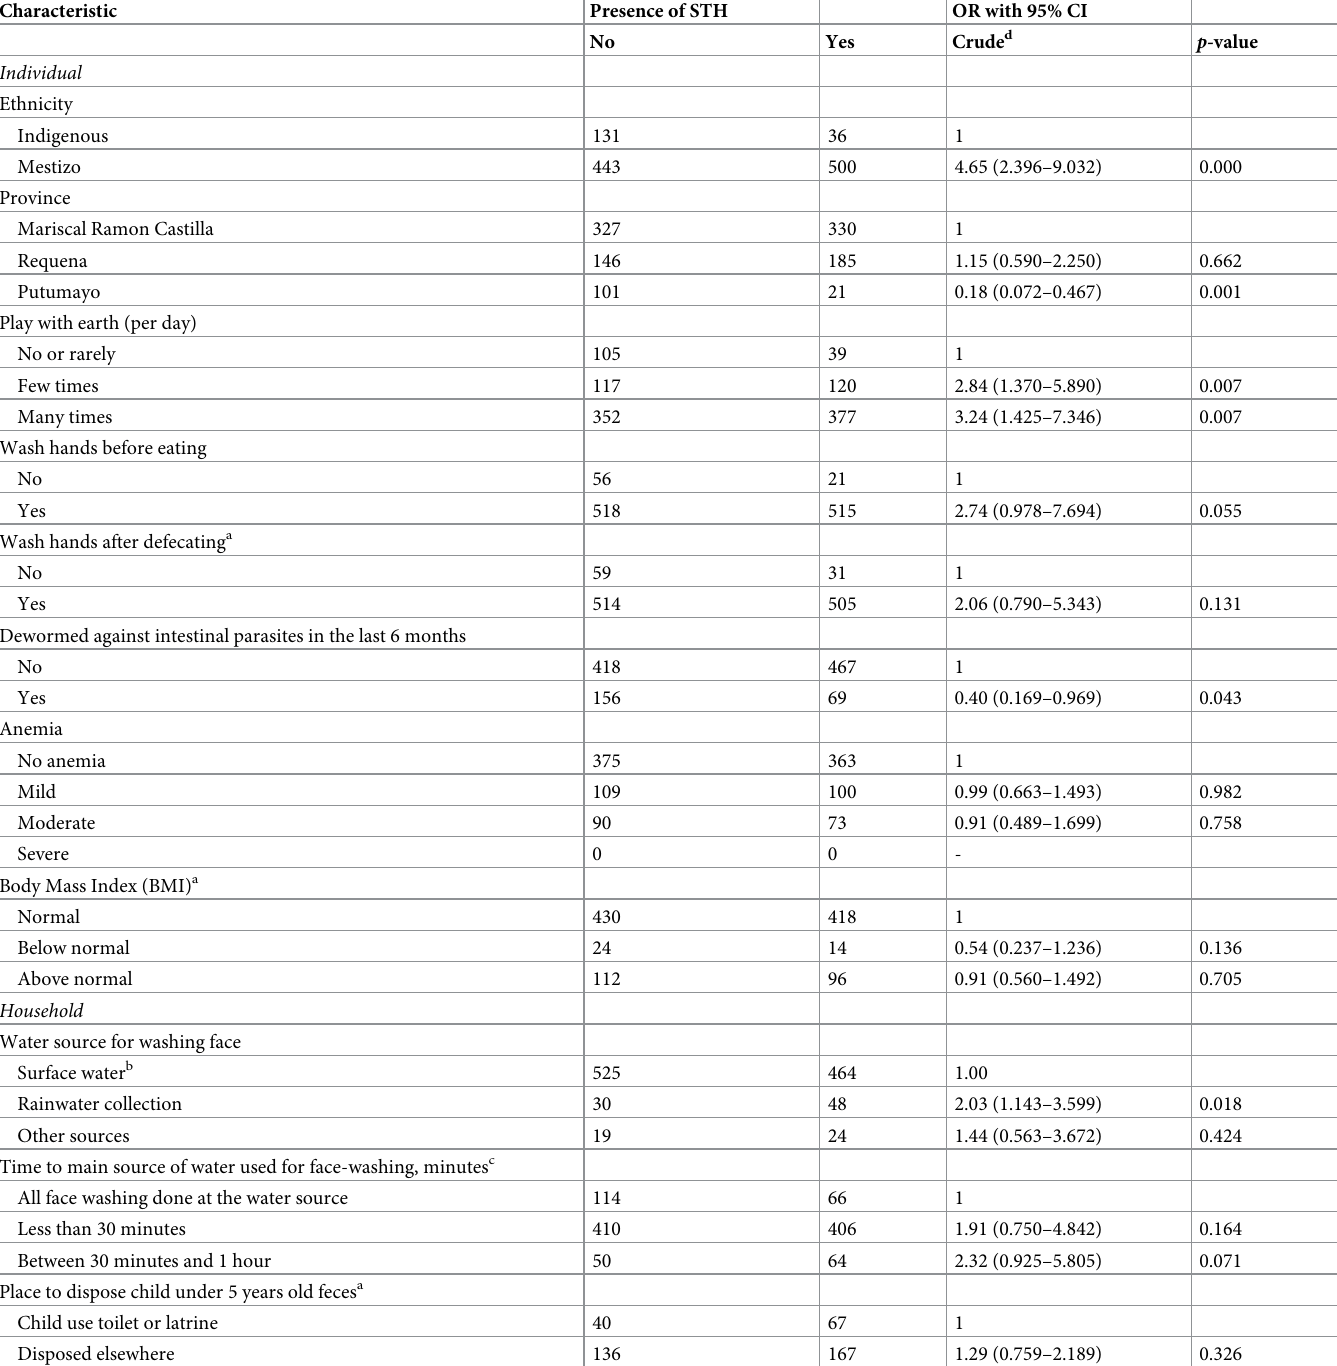
Table 9. Bivariate logistic regression analysis of factors associated with soil-transmitted helminthiasis (STH), among children aged 1–9 years, rural communities of Loreto Department, Peru